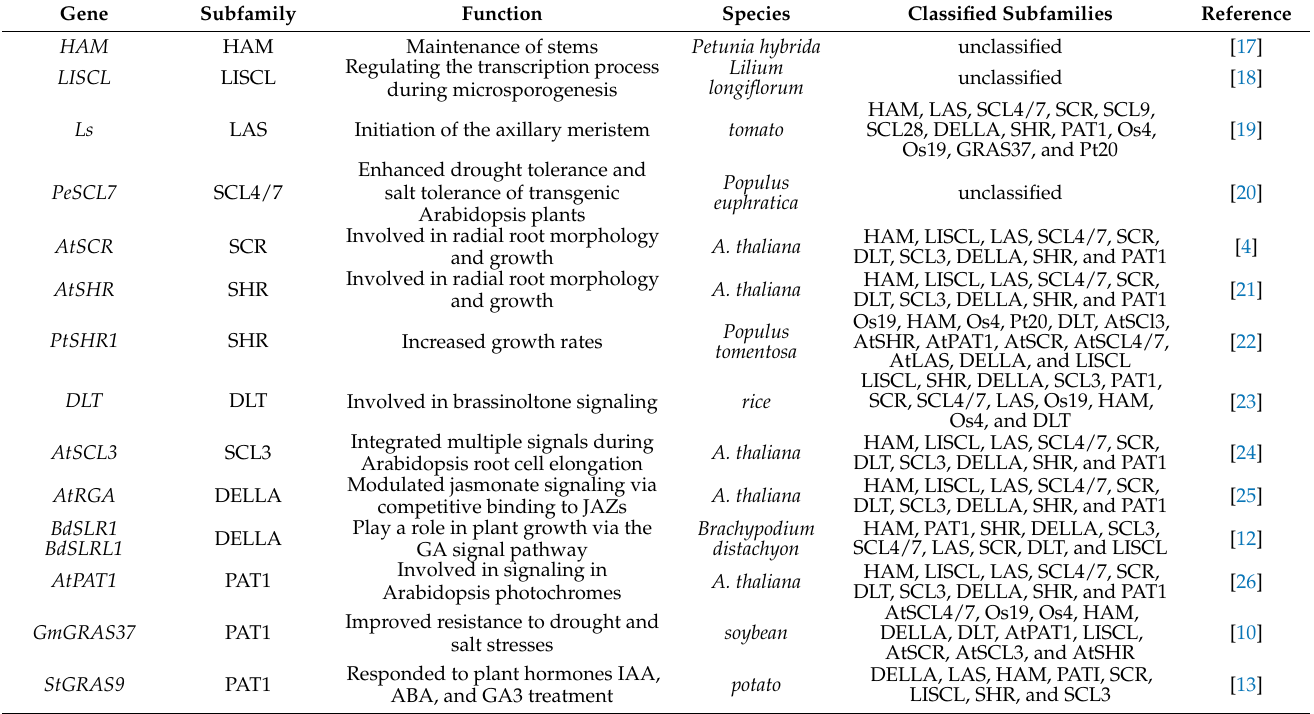
Table 1. Recent advances in biological functions of the GRAS transcription factor gene